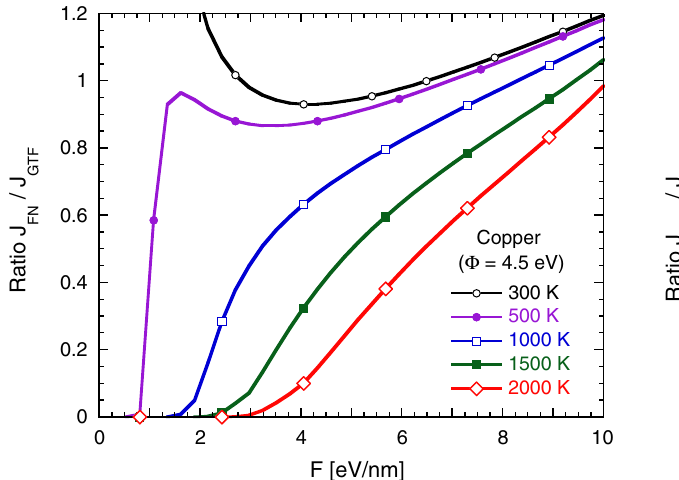
FIG. 19. (Color) Performance of the Richardson-Laue-Dushman (RLD) equation with Schottky barrier lowering to the general thermal-field (GTF) equation. The RLD equation in this approxi- mation is field dependent through the factor y .